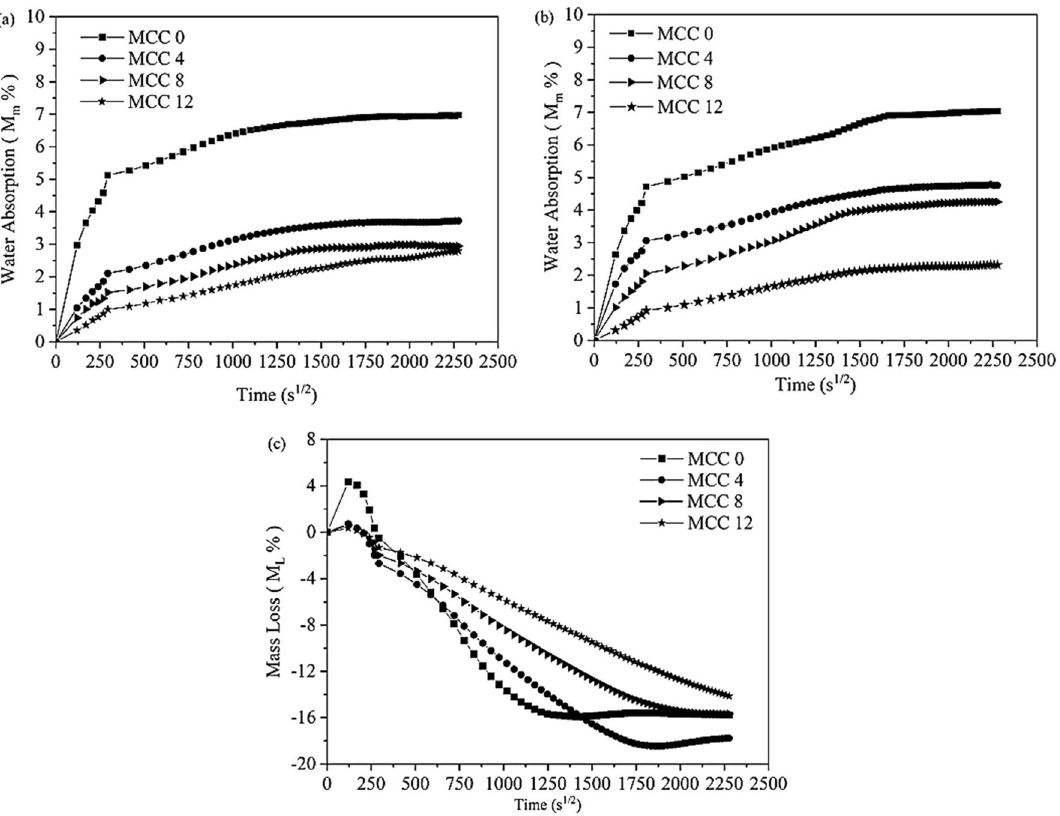
Figure 6. The curve of water absorption ( Mm ) composites immersed in: ( a ) distilled water, ( b ) seawater, and ( c ) an acidic solution.